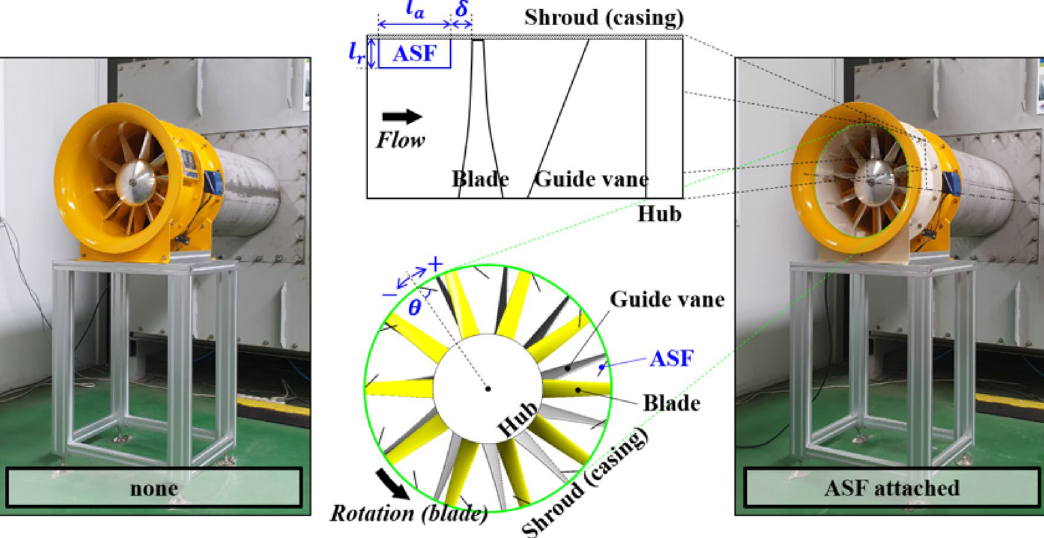
Figure 2. Photograph and schematic drawing for design parameters: case of none (left); case of ASF attached (right); meridional plane for radial length ( l r ), axial length ( l a ), and axial gap ( δ ) (mid-top); front view for number of fins ( Z ) and tangential angle ( θ ) (mid-bottom).